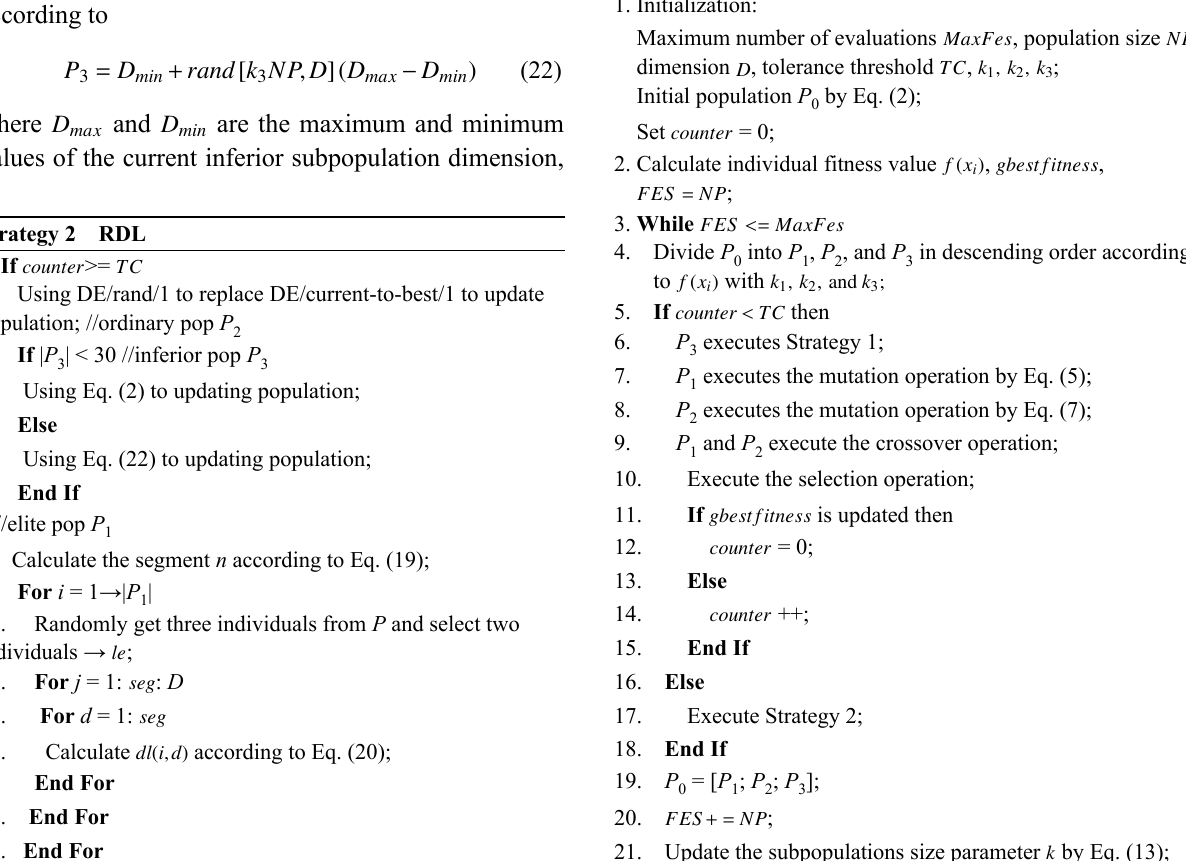
Algorithm 1 The p roposed ADLDE